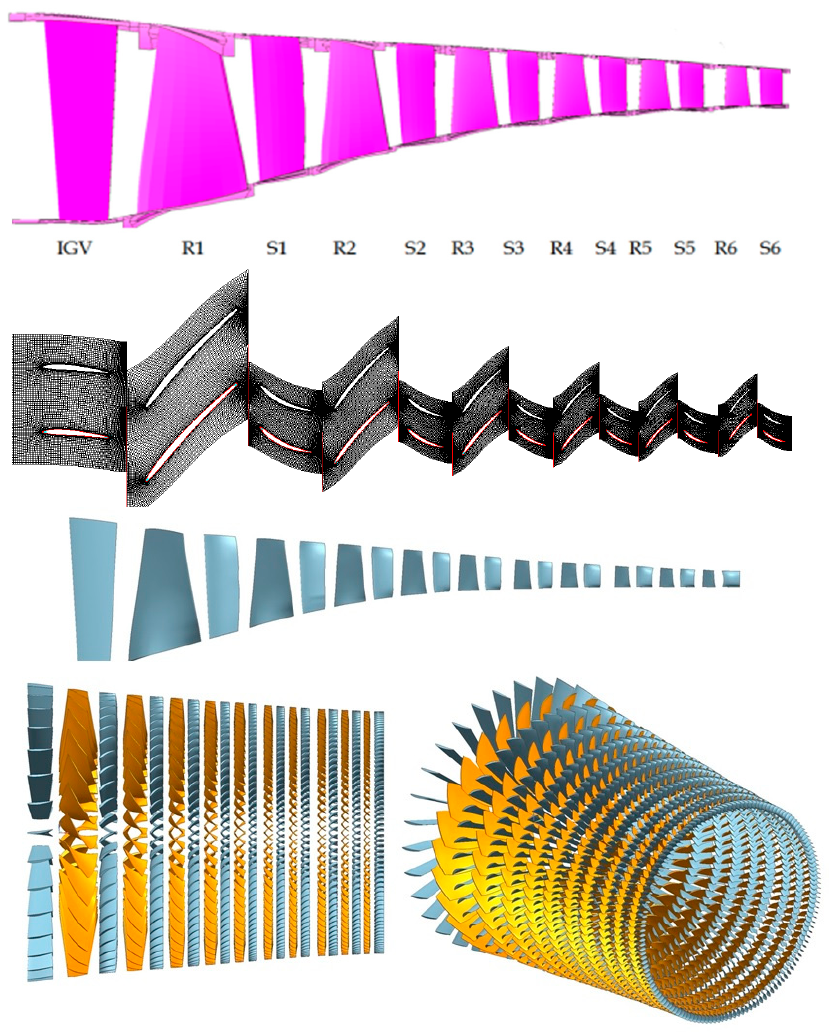
Figure 18. Comparison of blade angles of E 3 HPC rotor 3 generated by the tool with NASA report along with grid representation of first 6 stages and CAD for all 10 stages.